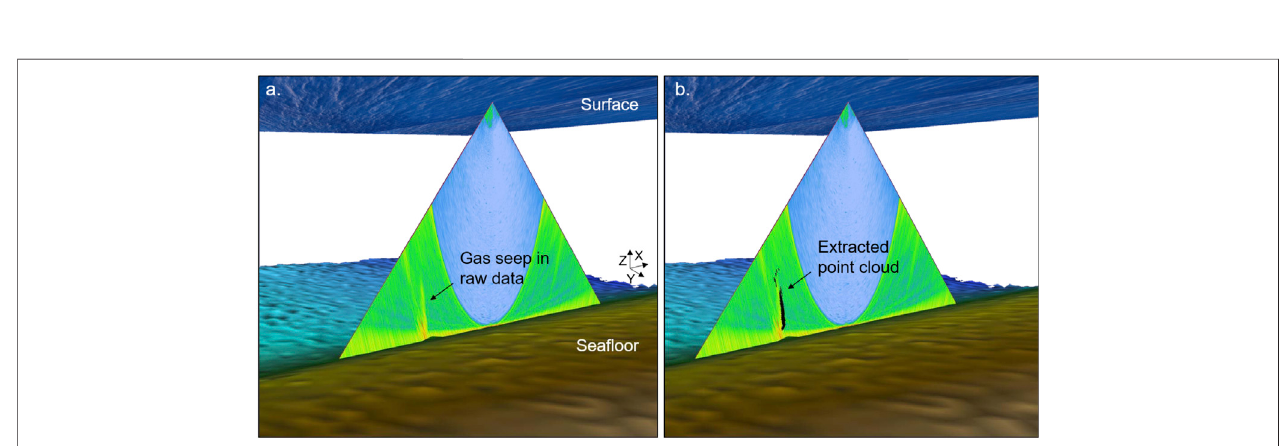
FIGURE 7 | 3-D image of classi fi ed point cloud on original water column fan (single ping); (A) Original WCD image and (B) classi fi ed point cloud overlaid on original data.